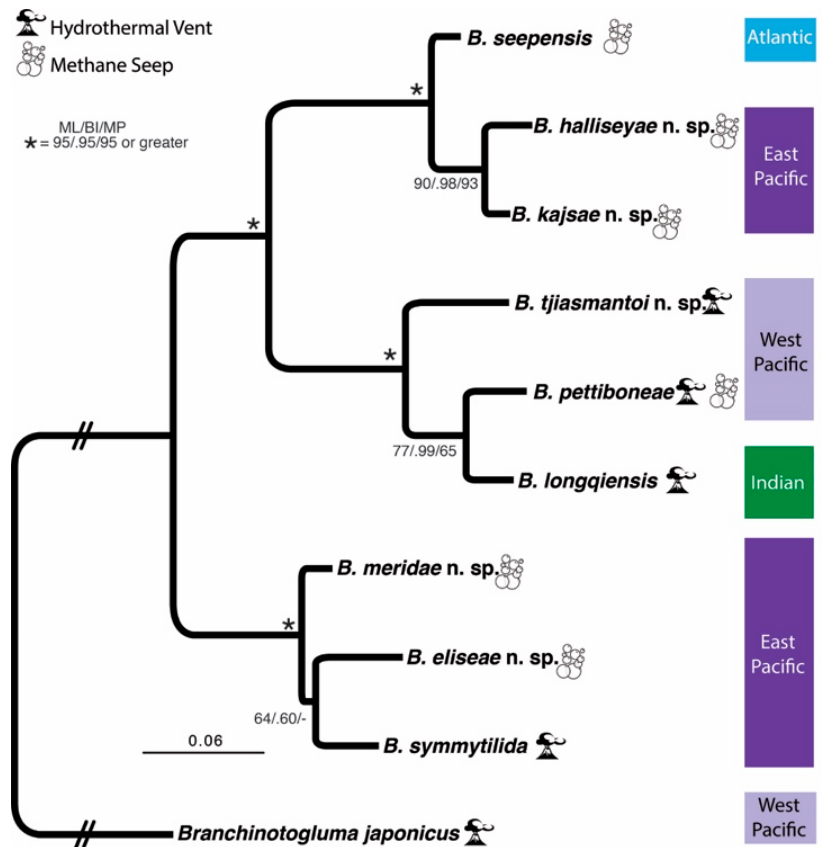
Figure 3. Maximum likelihood (ML) and Bayesian inference tree from the analysis of the combined sequences from COI, 16S, and ITS. The topology for the single maximum parsimony (MP) tree differed in showing Branchipolynoe eliseae n. sp. as sister to B. meridae n. sp. Numbers on relevant nodes are ML bootstrap BI posterior probability and MP jackknife below. * indicates 95% bootstrap/jackknife or greater and 0.95 posterior probability or greater; ‘-‘ indicates the node was not found.